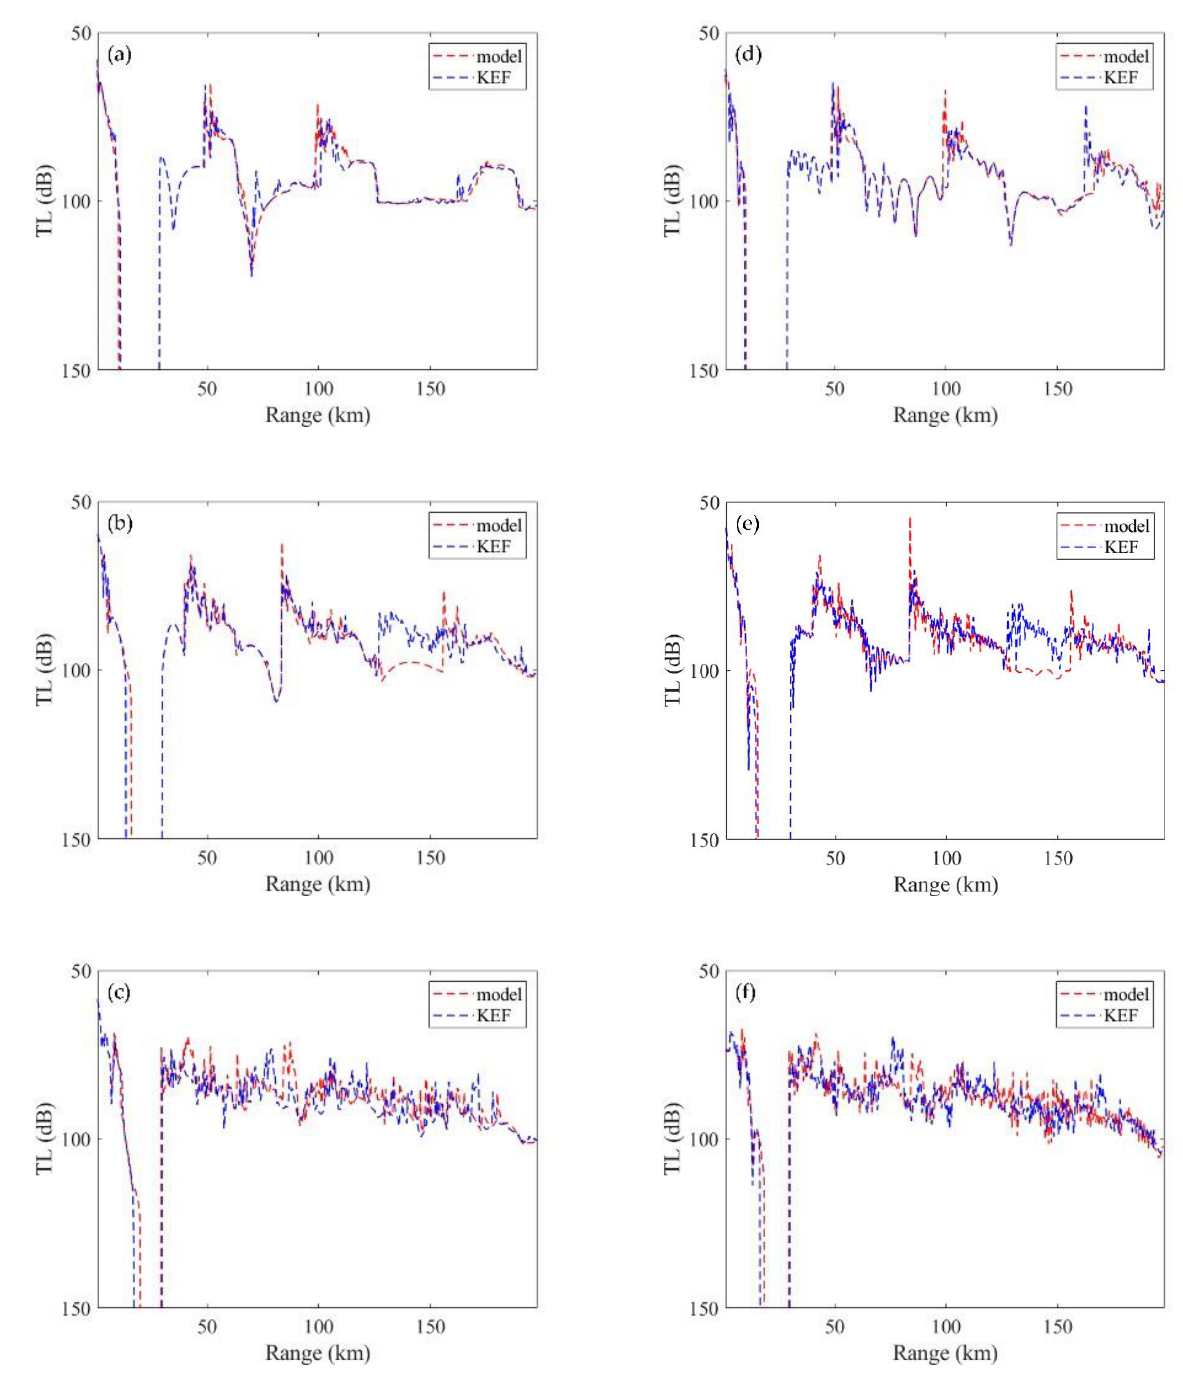
Figure 10. Comparison of the model and actual TL under different SD and frequency on 1 February: ( a ) f = 50 Hz, SD = 100 m; ( b ) f = 50 Hz, SD = 300 m; ( c ) f = 50 Hz, SD = 500 m; ( d ) f = 400 Hz, SD = 100 m; ( e ) f = 400 Hz, SD = 300 m; ( f ) f = 400 Hz, SD = 500 m. When the SD was 100 m, the difference between the TL calculated by the model and the TL calculated by the actual ocean front was very small at low and high frequencies. At 300 m, only on February 1st (Figure 10b,e), the calculation results of low frequency and high frequency showed a small difference after passing the frontal zone. At 500 m, in terms of the overall trend, the results of the model and the actual results also showed many similarities.